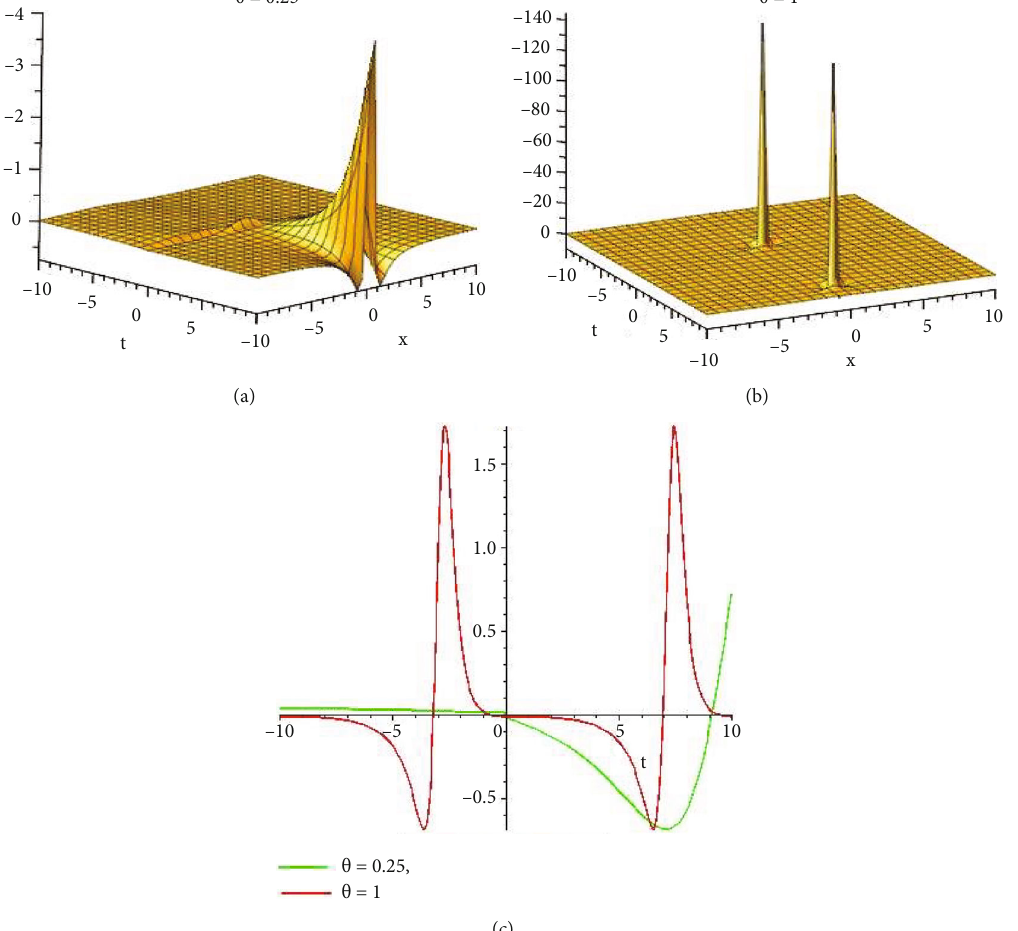
, t Þ . (a, b) 3D plot and (c) 2D combined stripe plot for x = 1 12,13 ð x